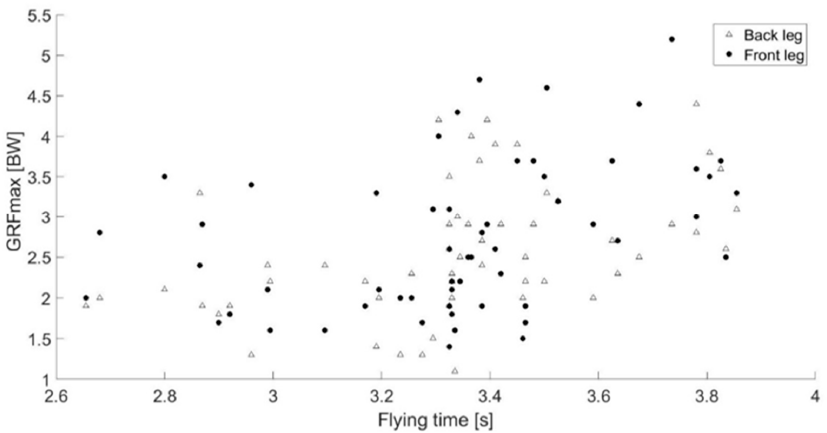
Figure 3. Normal GRF max acting on the rear and front leg during telemark in relation to the flying time for 56 jumps.